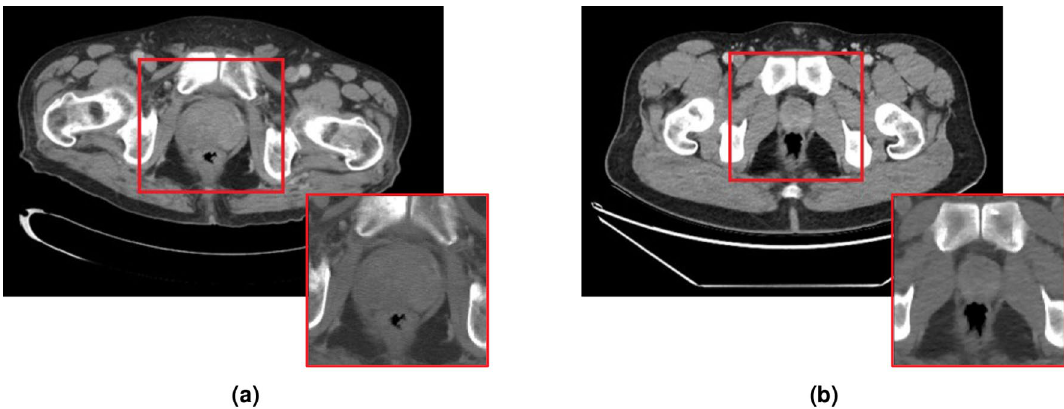
Figure 1. Two CT scan slices from the dataset: ( a ) from a confirmed csPCa patient, and ( b ) from a patient with no known prostate cancer (control). Both include a red square indicating the cropped prostate region, and the pre-processed version on the lower right